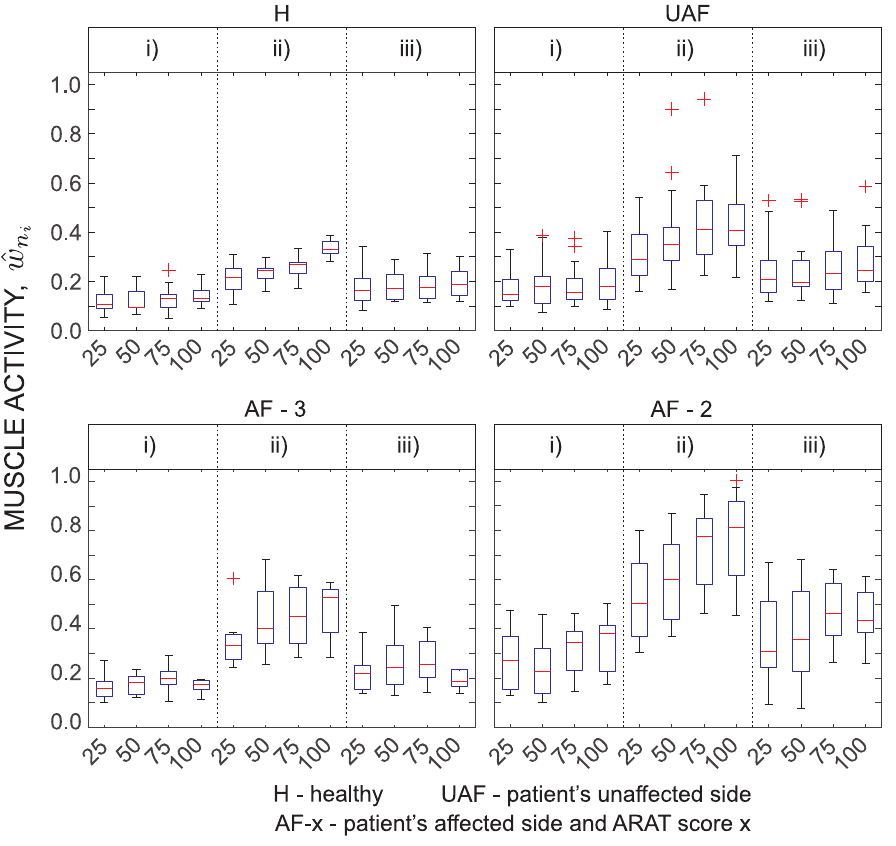
Figure 9. Muscle activity ˆ w n for four grasp tasks. Four blocks: Side length 25 mm, 50 mm, 75 mm, and i 100 mm. Three phases: (i) reach to grasp phase; (ii) transfer phase; and (iii) return phase. Presented groups are: H, healthy (top-left); UAF, patient’s unaffected side (top-right); AF-3, patient’s affected side with Score 3 (bottom-left); and AF-2, patient’s affected side with Score 2